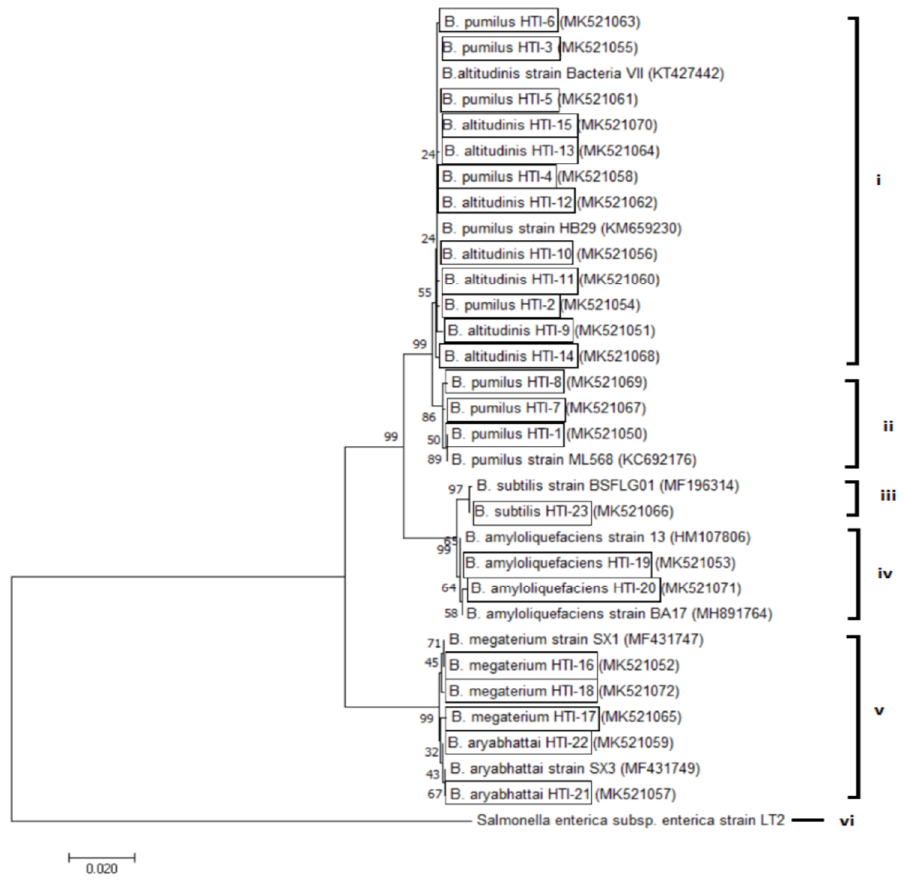
Figure 1. Evolutionary relationships of taxa. The evolutionary history was inferred using the neighbor-joining method. An optimal tree with the sum of branch lengths = 0.34080293 is shown. The percentage of replicate trees in which the associated taxa clustered together in the bootstrap test (1000 replicates) is shown next to the branches. The tree is drawn to scale, with branch lengths in the same units as those of the evolutionary distances used to infer the phylogenetic tree. The evolutionary distances were computed using the maximum composite likelihood method and are in the units of the number of base substitutions per site. The analysis involved 32 nucleotide sequences. All positions containing gaps and missing data were eliminated. There were a total of 1405 positions in the final dataset. Evolutionary analyses were conducted in MEGA7.